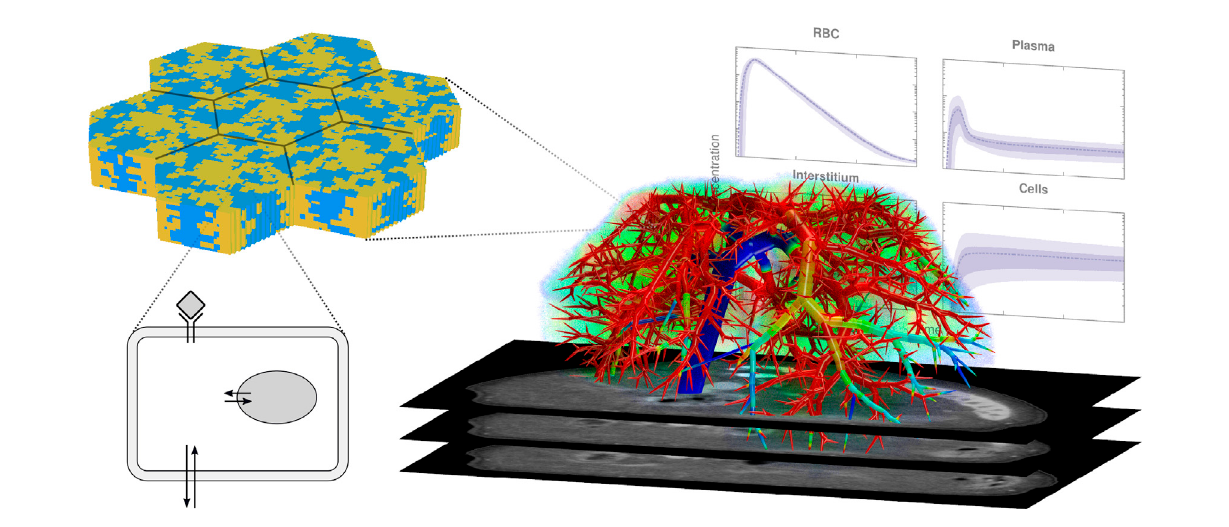
FIGURE 1 Aninvestigationofhepaticfunctionsrequiresanunderstandingofmultiplespatialandtemporalscales.Perfusionconnectstheindividualcellstothe organism,transportingnutrients,xenobiotics,andmetabolites.Functionsofcellsmaydependontheirlocations,theuptakeandexcretionofcompounds across hepatocyte membranes may need the assistance of transporter proteins. CT slices, vascular tree, plots in the background: adapted from https:// doi.org/10.1371/journal.pcbi.1003499.g001 (license CC-BY